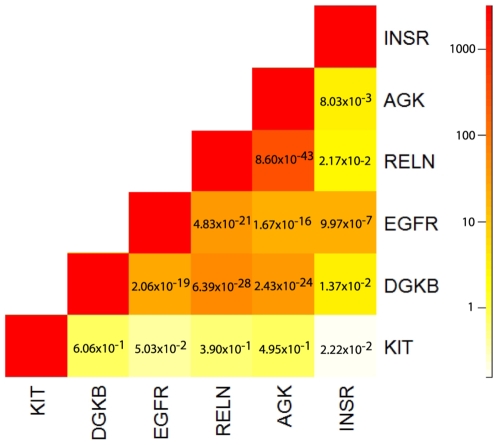
Heatmap of correlation, as measured by odds ratio estimates, between amplification status among six kinase/transferase activity genes showing signs of somatic allelic selection.Values above one indicate amplification correlation, below one anti-correlation. Fisher's exact P-values are given in each heatmap pixel.